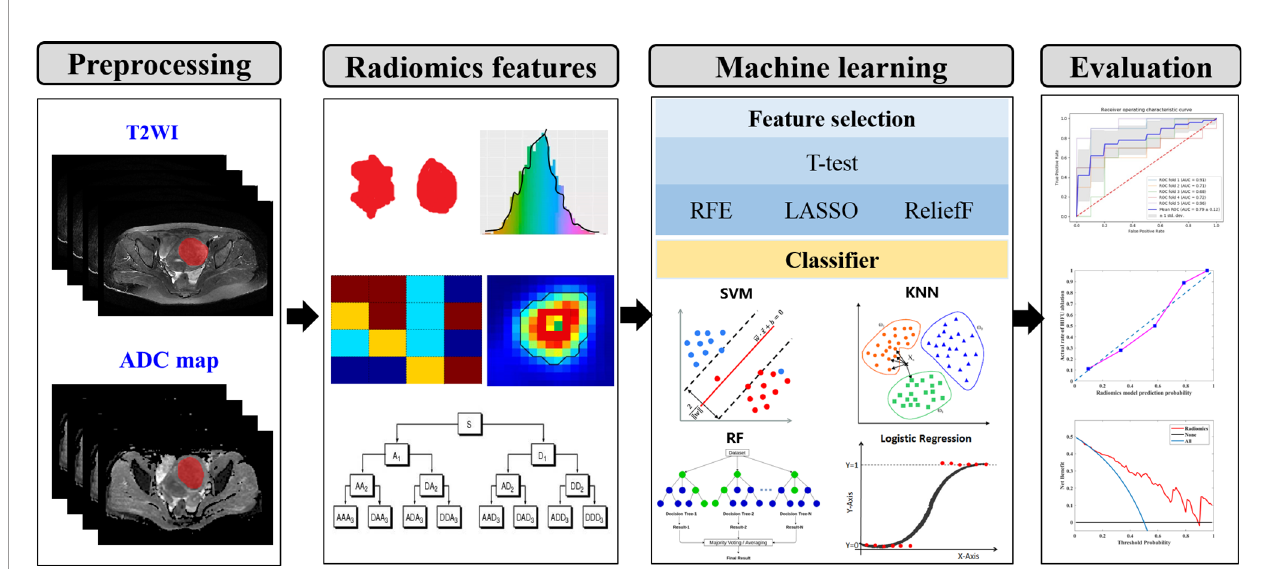
FIGURE 1 | The conceptual fl owchart of the present study. (I) lesion segmentation and preprocessing. (II) Quantitative radiomics features extraction. (III) Feature selection and classi fi cation. (IV) Performance evaluation of machine learning model. T2WI, T2-weighted imaging; RFE, recursive feature elimination; LASSO, least absolute shrinkage and selection operator; SVM, support vector machine; KNN, k-nearest neighbors; RF, random